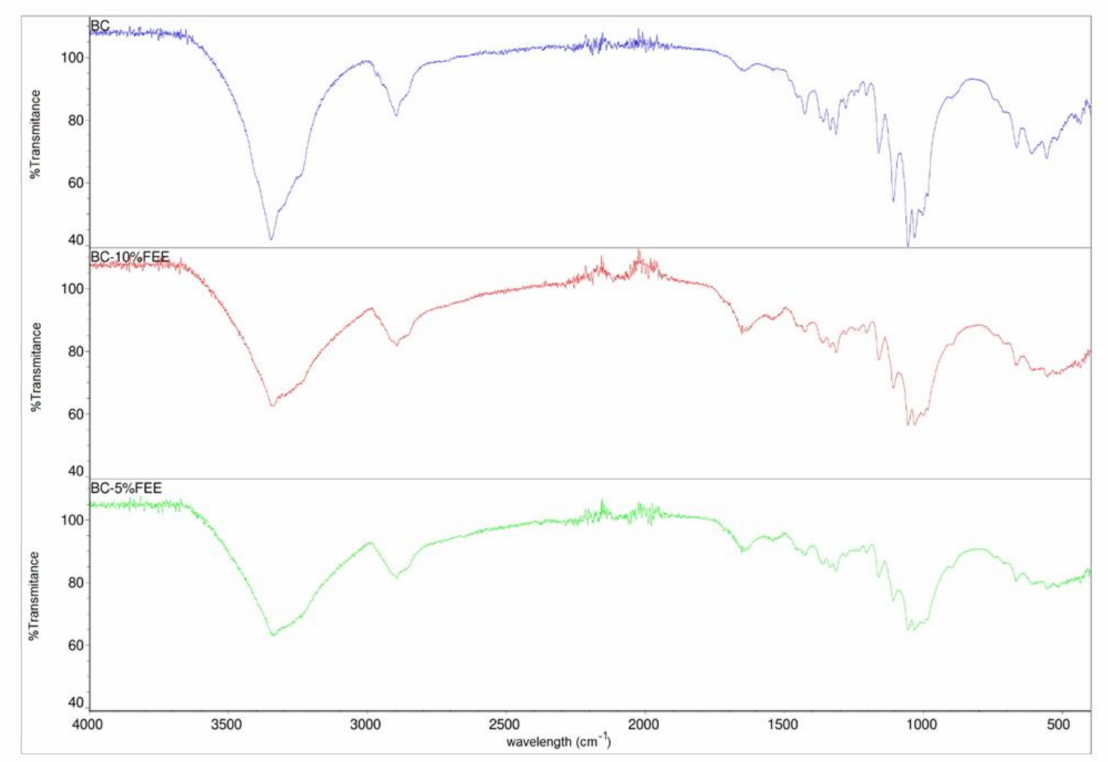
Figure 4. FTIR-ATR spectra of bacterial cellulose—BC (violet), BC-10%FEE (red) and BC-5%FEE (green).